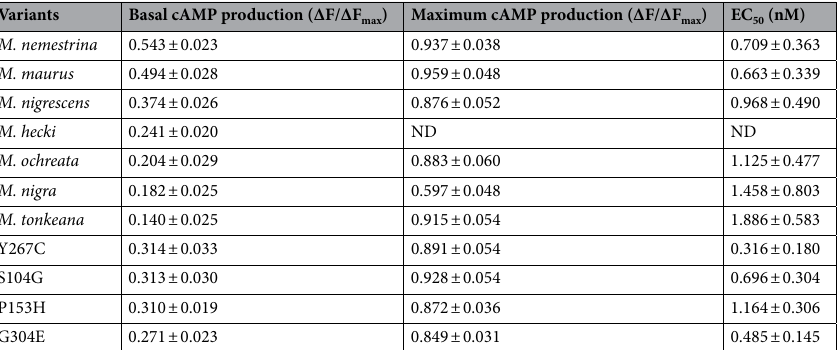
Table 2. Summary of basal cAMP production and maximun cAMP production. ‘Basal cAMP production’ is the cAMP accumulation without agonist stimulation; ‘Maximum cAMP production’ is the cAMP accumulation which reaches saturation in response to 100 nM α-MSH. The results are presented as mean ± SEM obtained from at least 3 times independent experiments. ND indicates ‘not determined’.